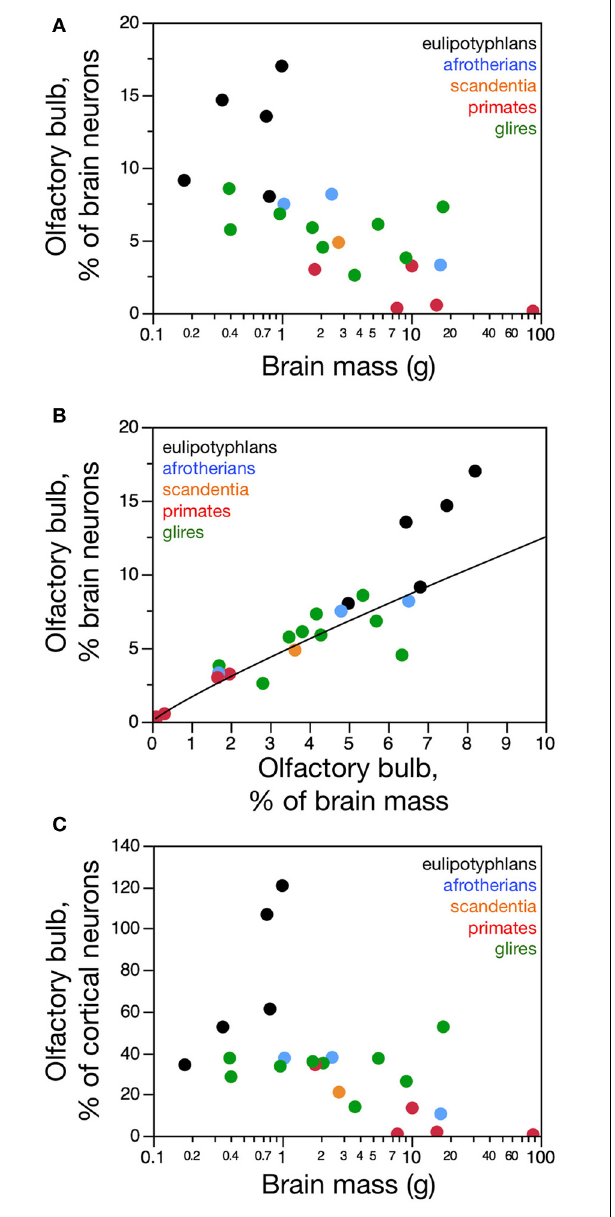
FIGURE 5 | Scaling of relative numbers of neurons in the olfactory bulb compared to the brain and cerebral cortex. (A) The relative number of neurons in the olfactory bulb expressed as a percentage of the number of neurons in the brain (excluding the olfactory bulb) is not significantly correlated with brain mass within any of the mammalian orders examined, although it decreases with increasing brain mass across all species combined. (B) The relative number of neurons in the olfactory bulb increases with increasing relative mass of the olfactory bulb (both compared to the whole brain) across primates, glires and afrotherians combined, as a power function of exponent 0.877 ± 0.054. (C) The relative number of neurons in the olfactory bulb expressed as a percentage of the number of neurons in the cerebral cortex is not significantly correlated with brain mass within any of the mammalian orders examined. Eulipotyphlan data from Sarko et al. (2009). Afrotherian data from Neves et al. (2014). Glires, data from Herculano-Houzel et al. (2011) and this study. Primates and scandentia, data from this